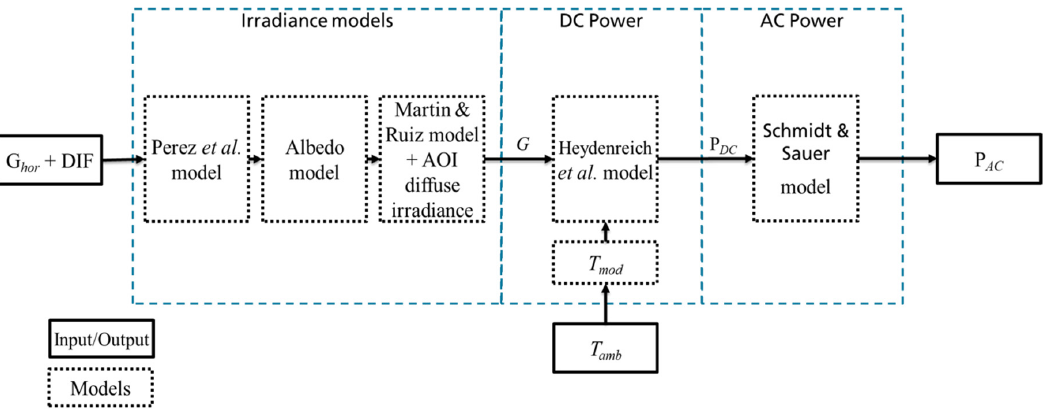
Figure 2. PV power simulation model chain steps.